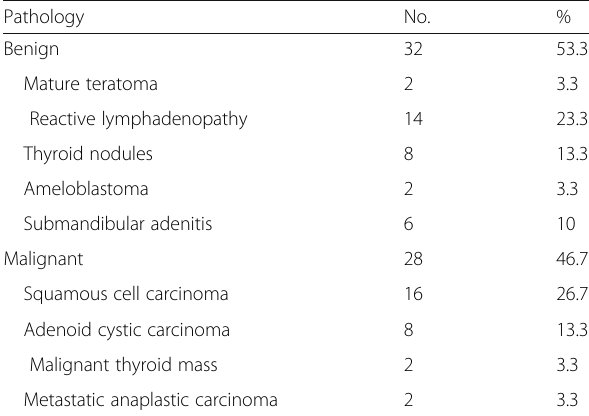
Table 1 Distribution of the studied cases according to